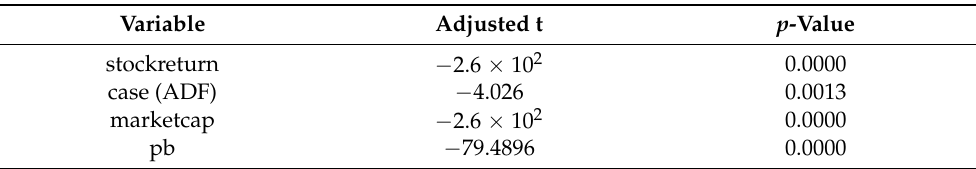
Table 4. The impact of COVID-19 on the Vietnamese stock market during pre-lockdown, lockdown and second wave